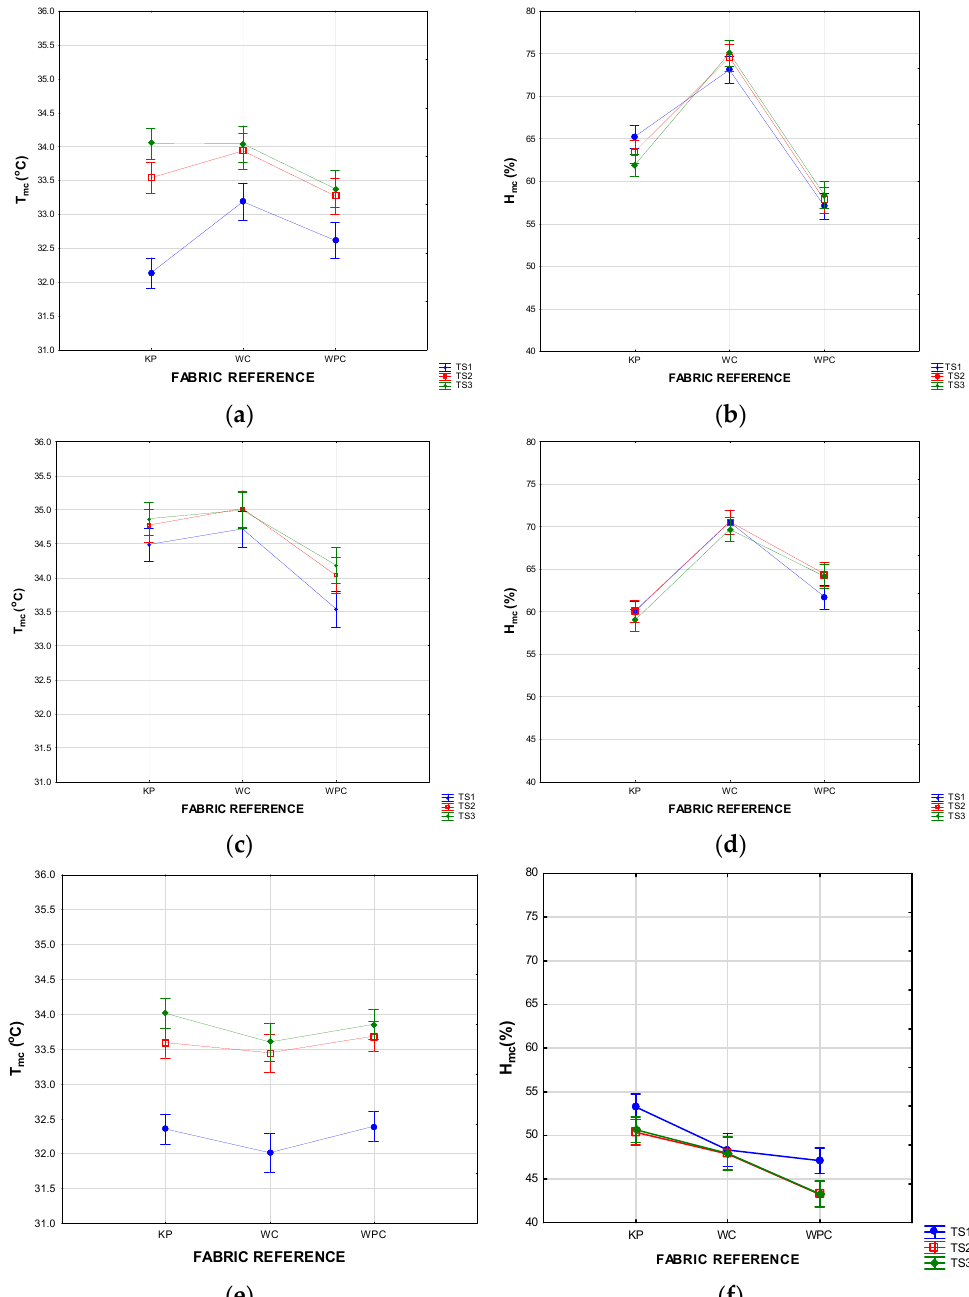
Figure 11. Two-way ANOVAs for T mc and H mc for all the mask styles interpreted per fabric type and time segment. ( a ) Pleated mask (style E); ( b ) pleated mask (style E); ( c ) mask with filter (style EF); ( d ) mask with filter (style EF); ( e ) shaped mask (style S); ( f ) shaped mask (style S).